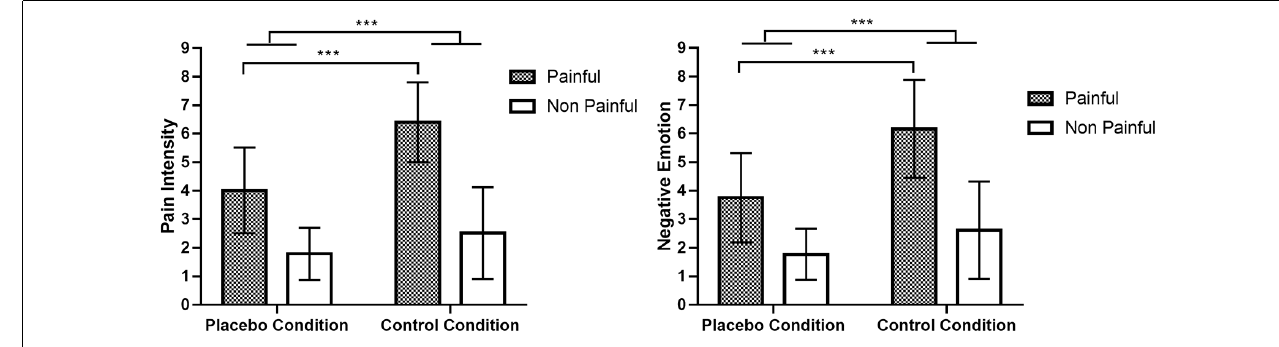
FIGURE 2 | Ratings of pain intensity and negative emotion induced by pain and no pain pictures. Comparing placebo and no-placebo control conditions, pain pictures induced higher ratings of pain intensity and negative emotion in the no-placebo control condition compared with the placebo condition ( p < 0.001), and the difference between pain and no pain pictures was also much higher in the no-placebo control condition than in the placebo condition ( p < 0.001). *** p <